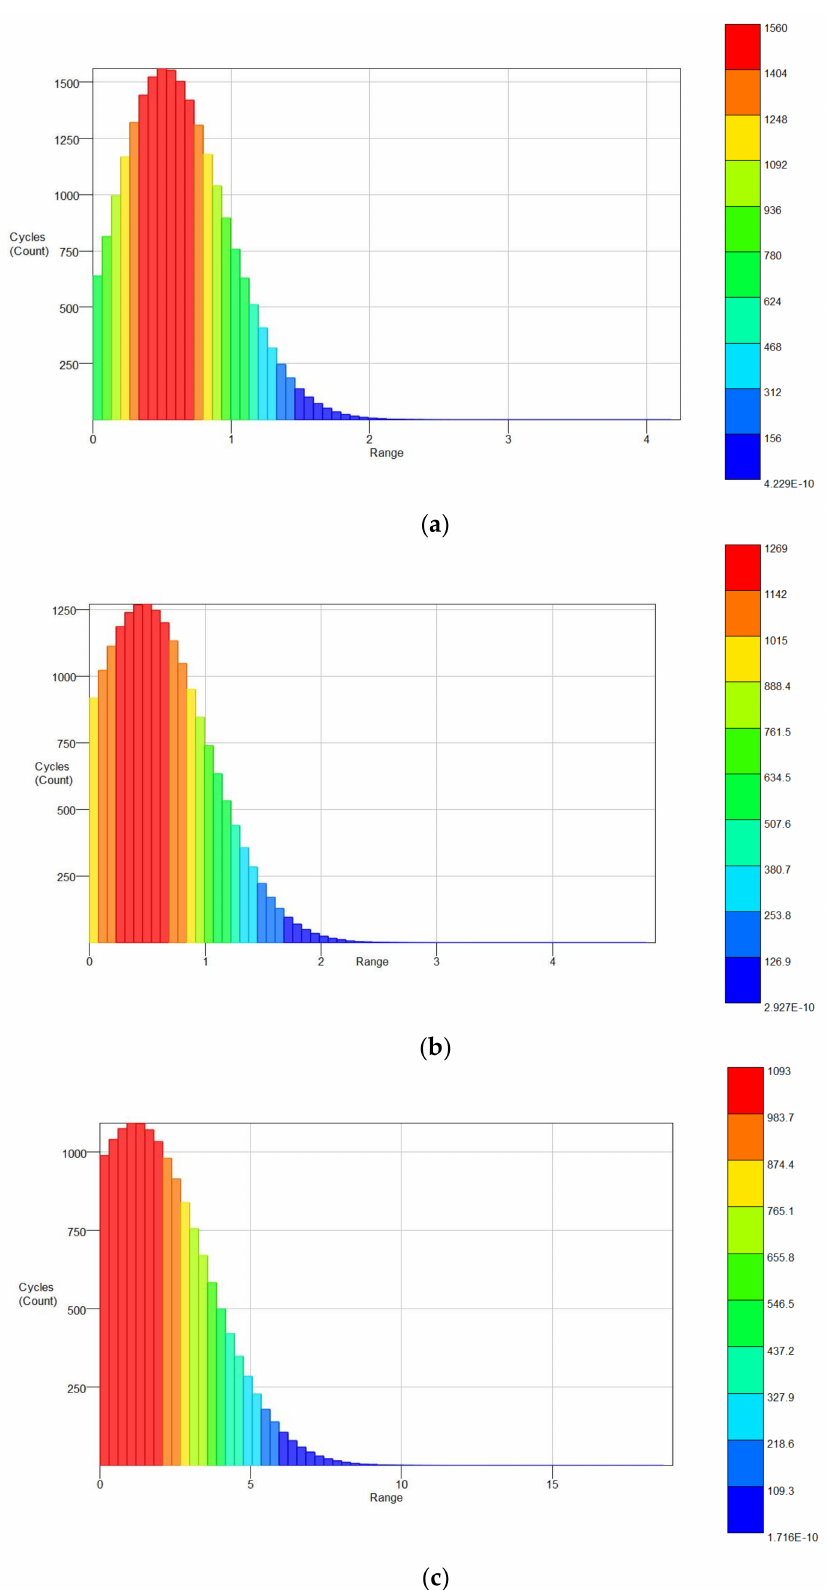
Figure 8. Lalanne PSD cycle count for different roads: ( a ) highway; ( b ) residential; and, ( c )